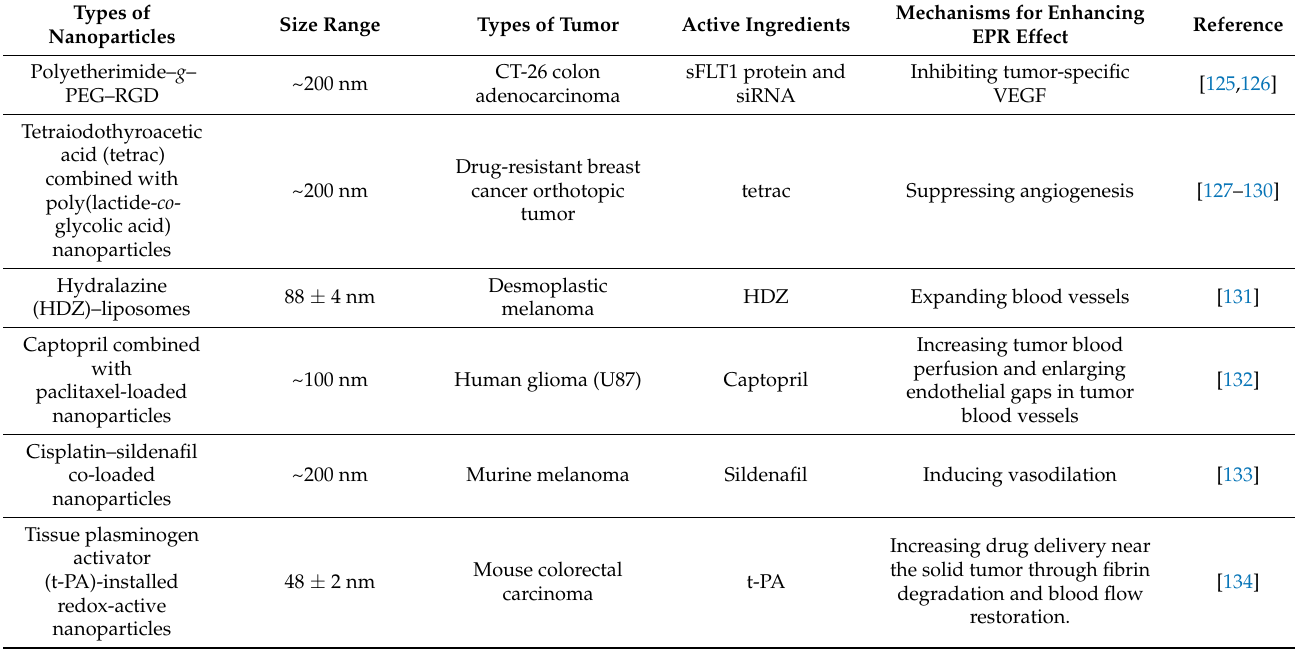
Figure 1. Schematic illustration of the impact of pharmacological vascular regulation strategies on tumor vasculature and tumor-targeted drug delivery. Vascular permeability enlarges the gap between ECs by vasodilating and increasing the gap between ECs and perivascular cells. Vascular normalization promotes vascular maturation and improves vascular perfusion, thereby restoring the morphology and function of tumor vasculature to a certain extent. Vascular rupture enhances vascular permeability by disrupting the endothelial lining while reducing perfusion (especially in immature vessels). Vascular facilitation increases relative blood volume in tumors by increasing vascular density and distribution. Reproduced from Ojha [20]. Table 2. Nanoparticles for enhancing the tumor enhanced permeability and retention (EPR)